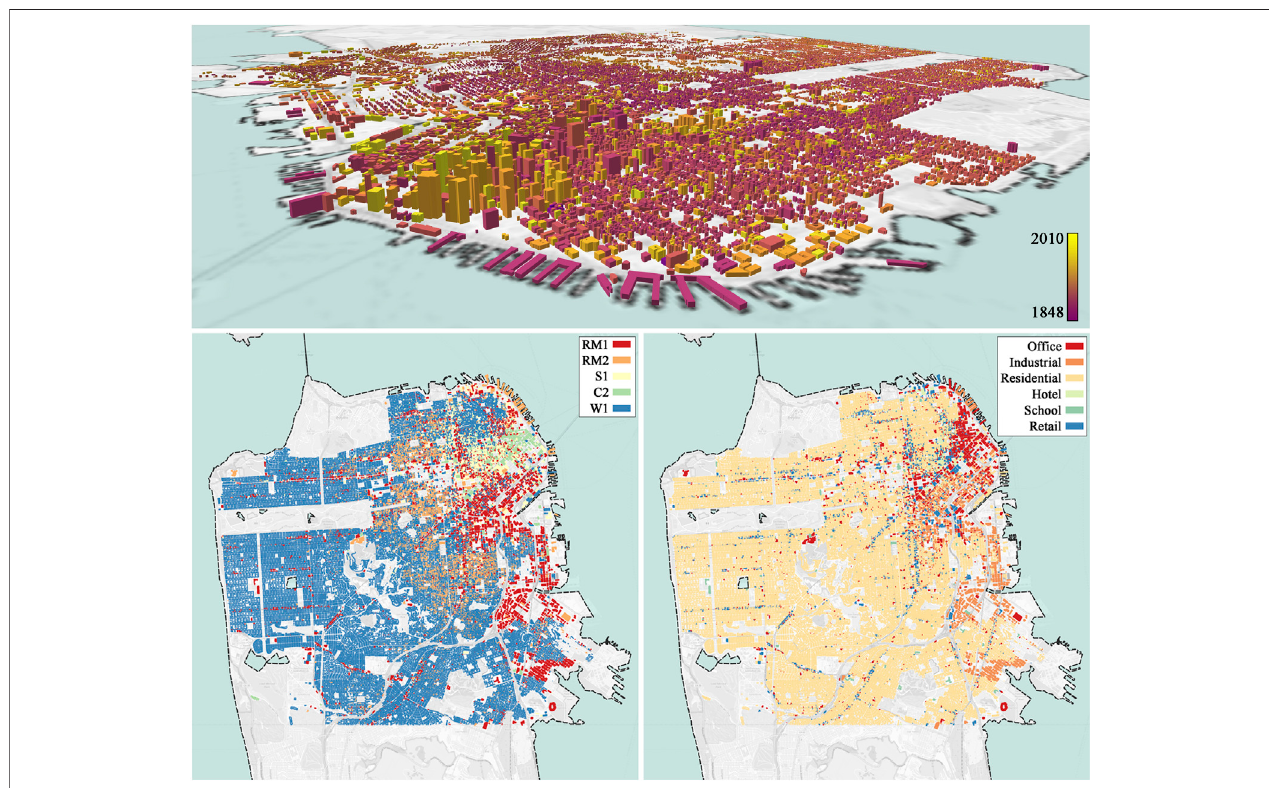
FIGURE 1 | Visualization of the geographical distribution of building variables in the San Francisco city area. Top) Buildings heights and year built. Bottom left) Structural types. Bottom right) Occupancy types.